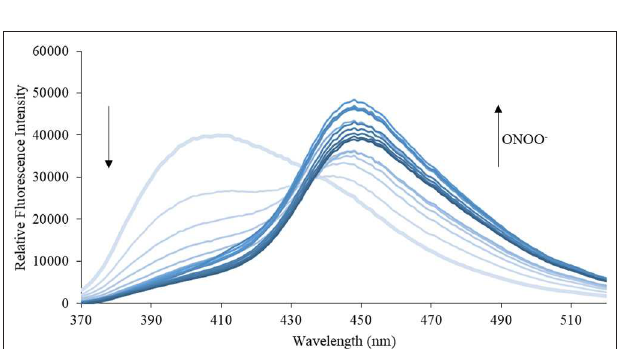
FIGURE 7 | Emission spectra for CE (5 µ M) in the presence of ONOO − (1, 2, 3, 4, 5, 6, 7, 8, 9, 10, 15, 20, 25, 30, 40, 50 µ M) in PBS buffer, pH = 7.4 at 25 ◦ C. Fluorescence intensities were measured with λ ex = 340 (bandwith: 20) nm on a BMG Labtech CLARIOstar ® plate reader.